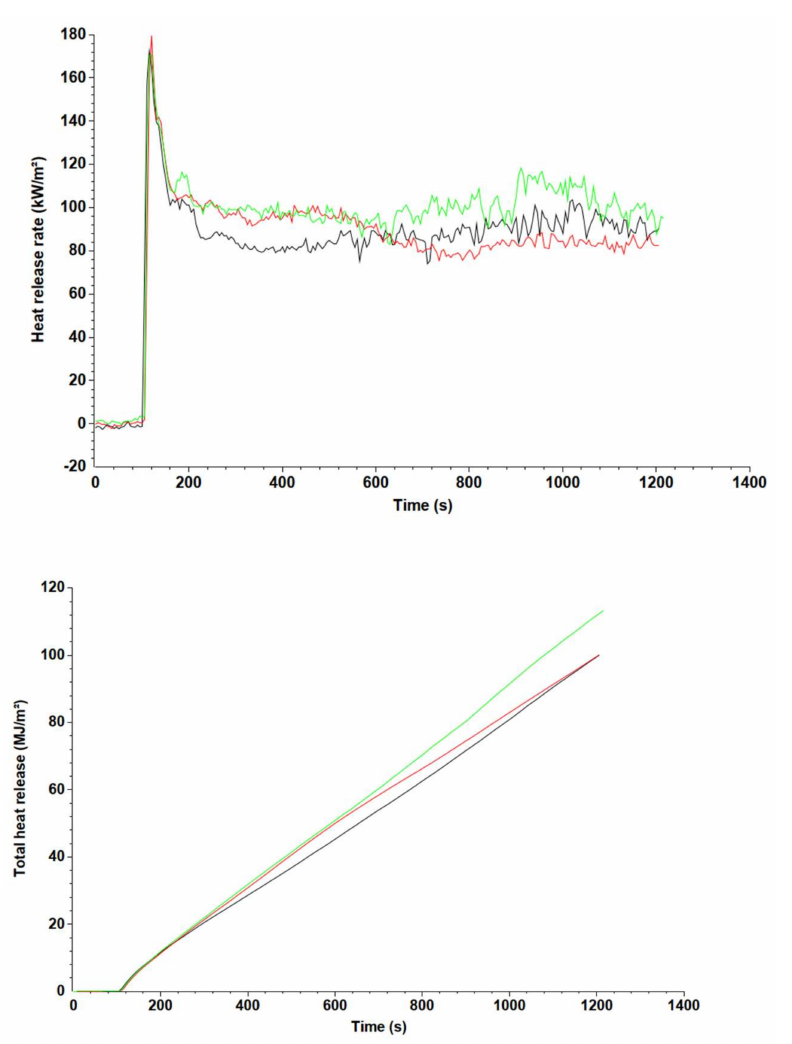
Figure 11. Amount of heat released during combustion of aramid panel (red—specimen 1; green— specimen 2; blue—specimen